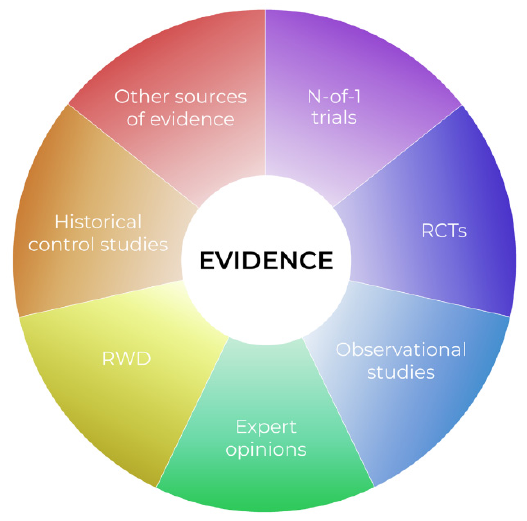
Figure 2. The complementary puzzle of evidence in rare diseases.